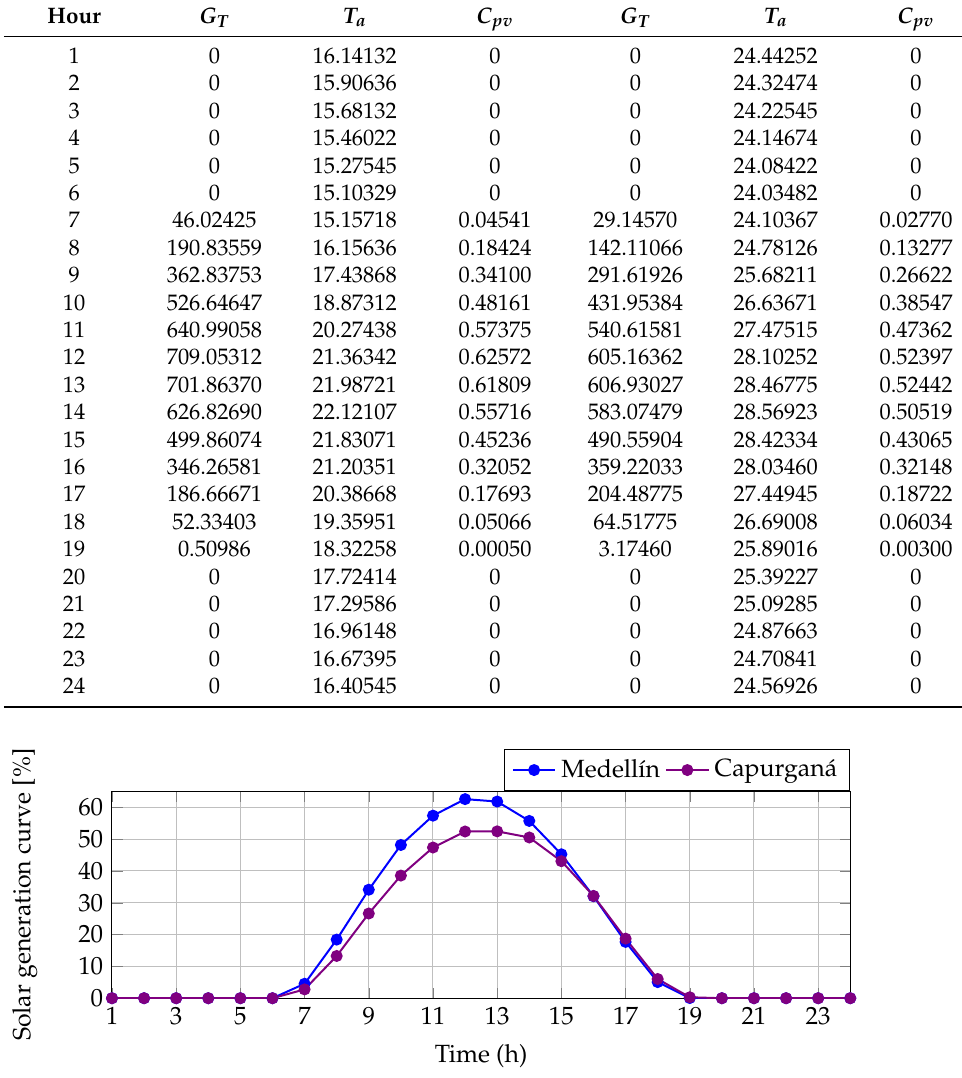
Figure 3. Expected generation profiles for Medellín and Capurganá,